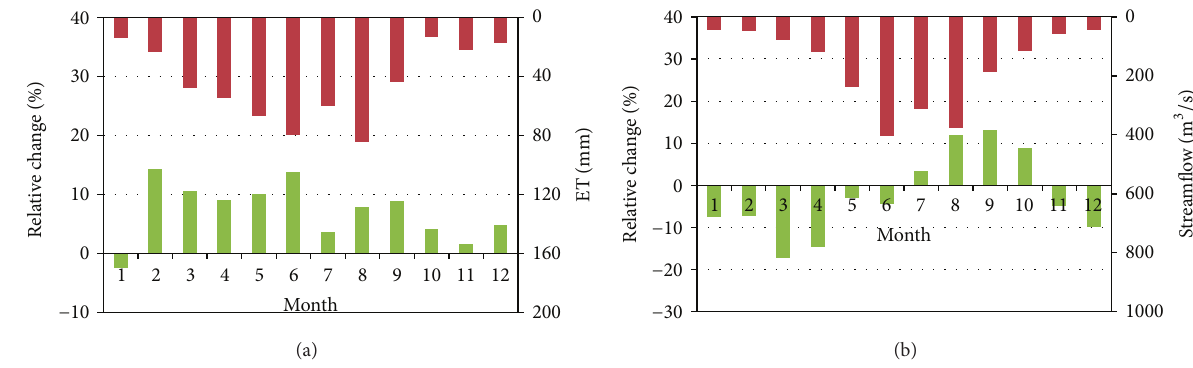
Figure 9: Basin averaged changes (green columns) of monthly mean ET and steamflow at Shilong station between baseline (red columns) and future climate scenario in the